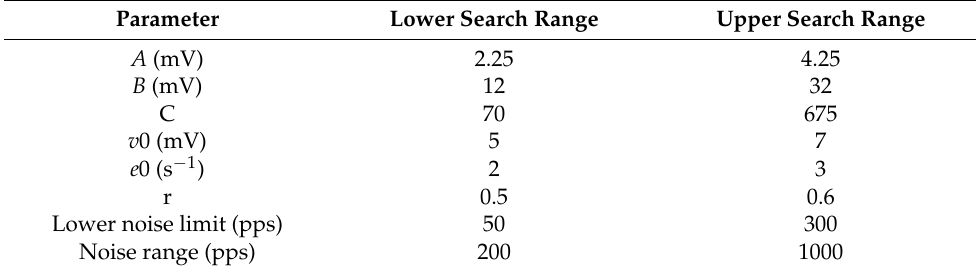
Table 2. Ranges of the search domains of particular parameters.